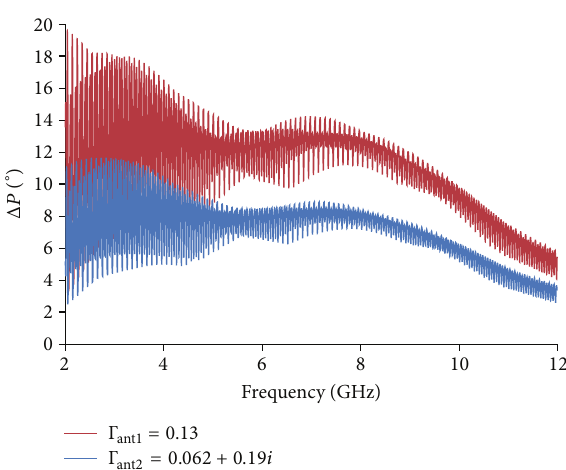
Figure 11: Maximum phase variation for different type of breathing movements simulated and measured.